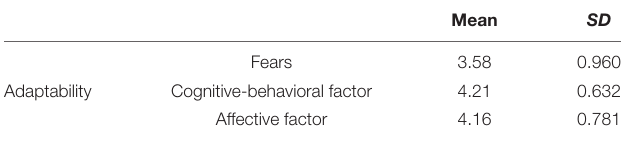
TABLE 4 | Mean statistics of the FCV19 and adaptability